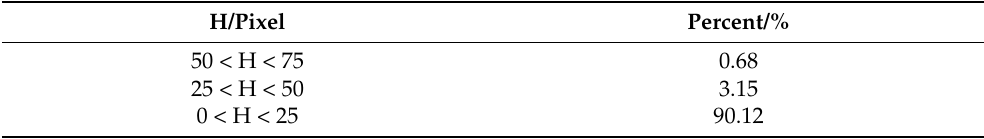
Table 2. The ratio of the absolute value H of the length and width and percent of false positives.